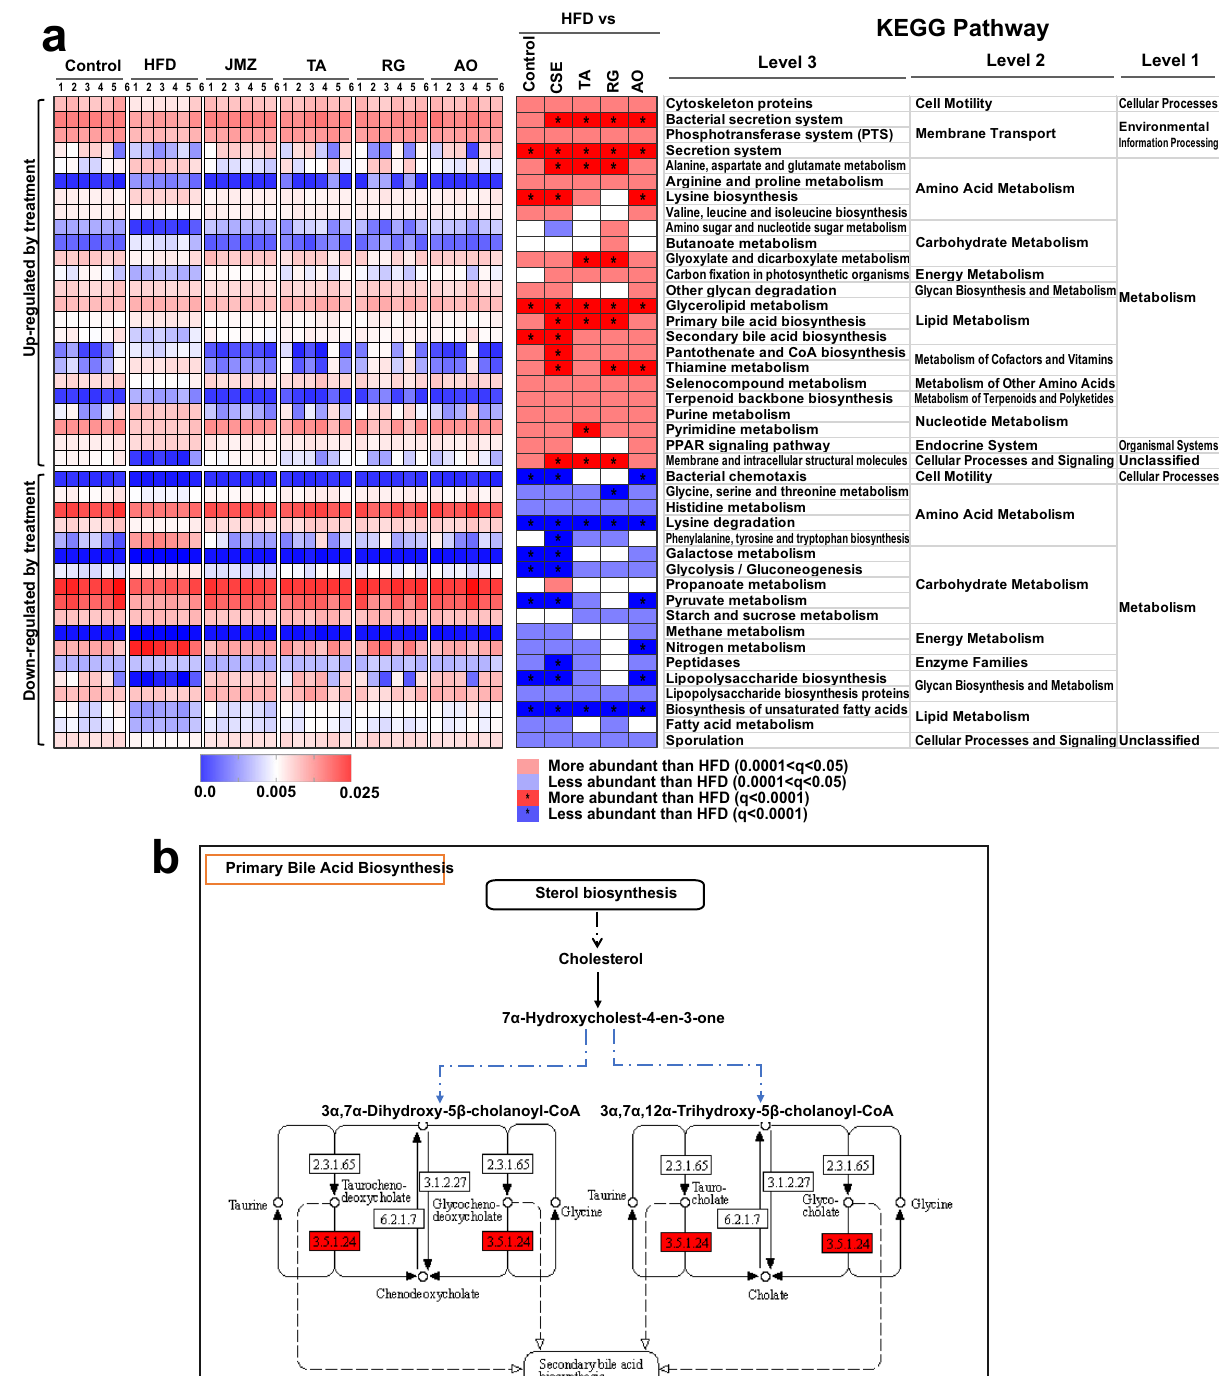
Fig. 6 KEGG pathway analysis. Metabolic pathway with signi fi cant enhancement by CSE treatment ( a ). The heatmaps on the left show that the relative abundance of several metabolic pathways was altered. Statistical analysis of the differences between the groups was performed using the original false discovery rate method of Benjamini and Hochberg. In the image, red represents increased relative abundance, blue represents decreased relative abundance, and * represents Q < 0.0001. The corresponding genus information is on the right. Effects of CSE on the primary bile acid biosynthesis pathway ( b